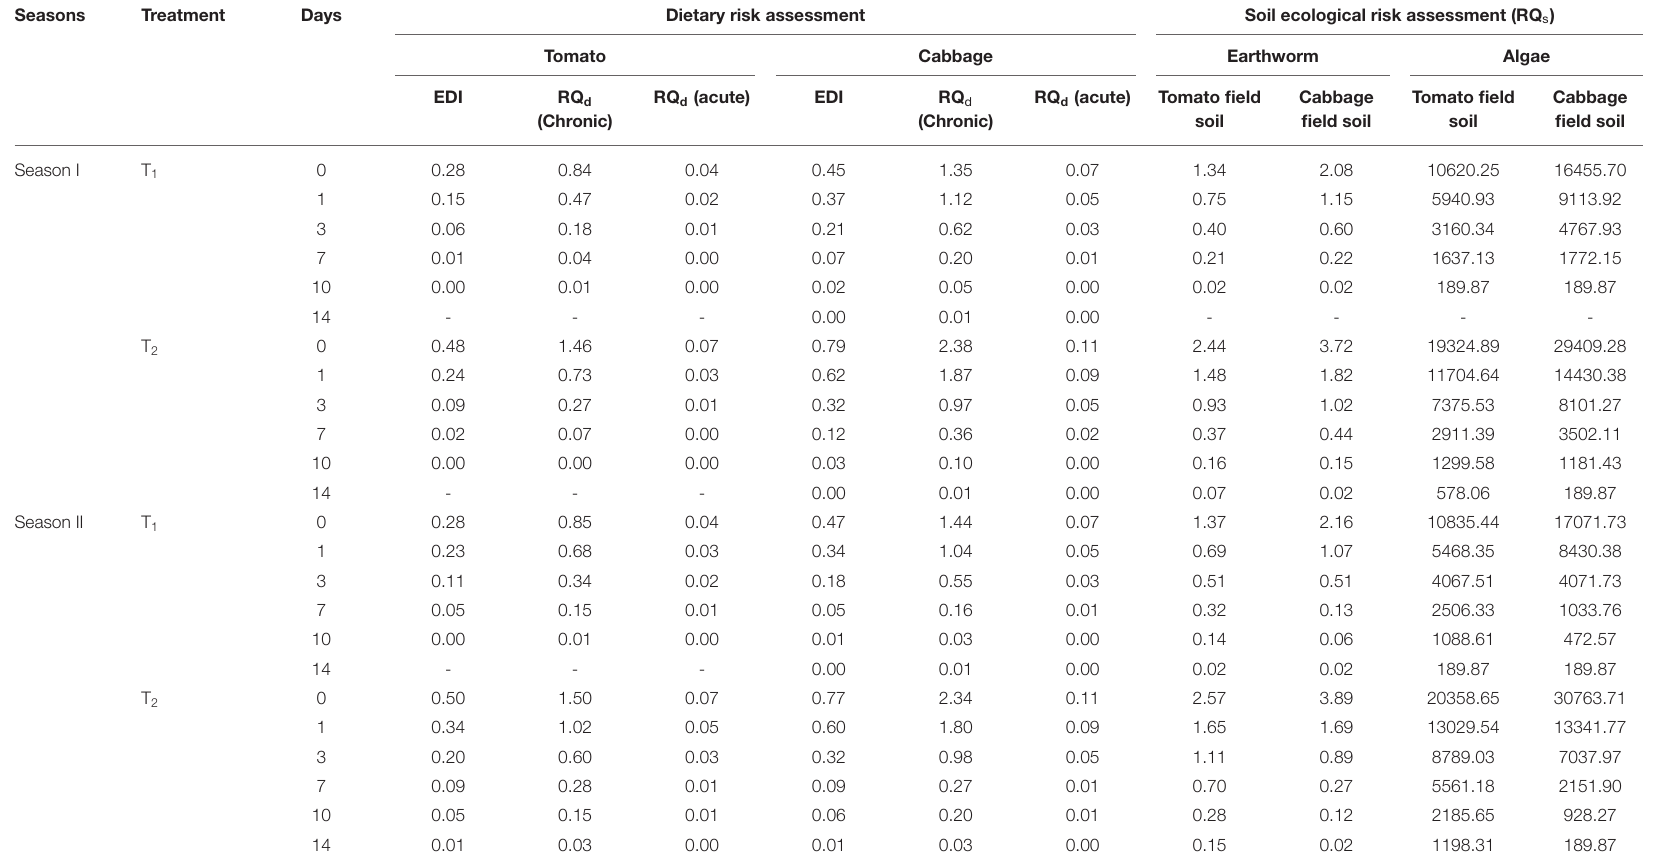
TABLE 3 | Dietary and soil ecological risk assessment of indoxacarb in tomato, cabbage, and soil. Seasons Treatment Days Dietary risk assessment Soil ecological risk assessment (RQ s )